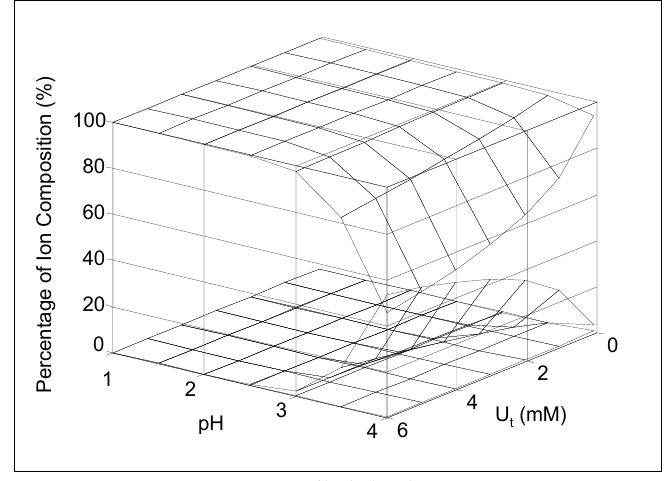
Fig. 13. Speciation of hydrolyzed ionic uranium Fig. 13 . Top mesh: UO 22+ ; Middle mesh: (UO 22+ ) (OH) 22+ ; Bottom mesh: (UO 22+ )(OH) + 2